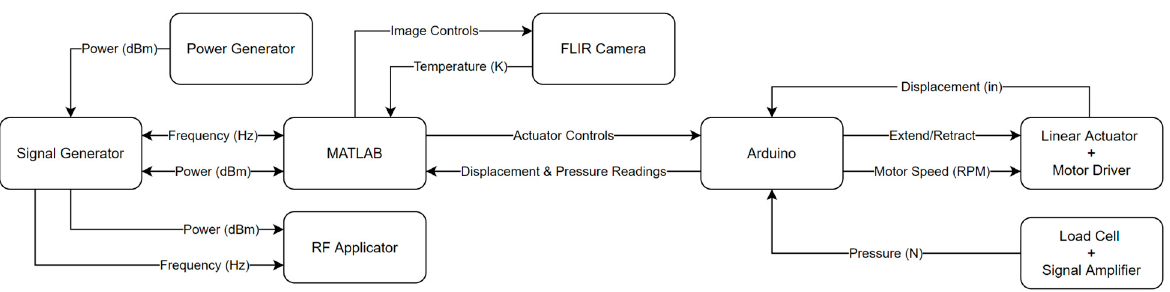
Figure 1. Schematic flow chart of the closed-loop control system for the radio-frequency welding machine.